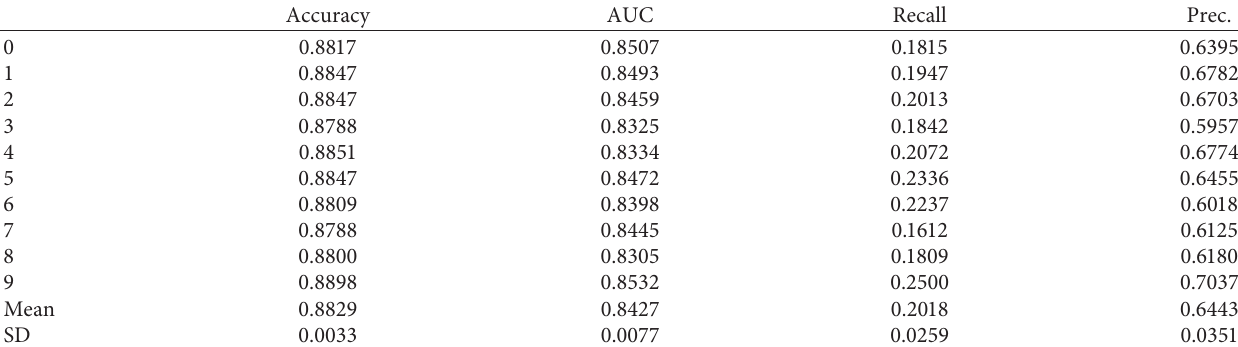
Table 2: Results from the cross-validation folds from the hyperparameter tuned training set.